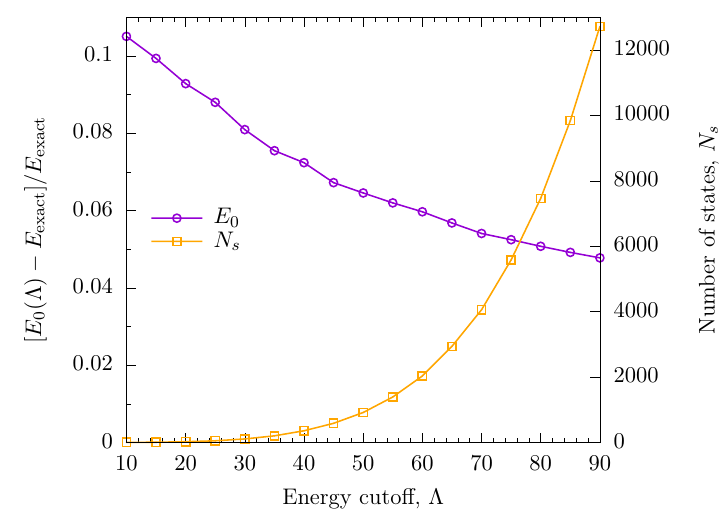
Figure 1: The ground state energy E number of basis states N the Hamiltonian (1) with c with N = 10 particles at unit density, using the truncated spectrum